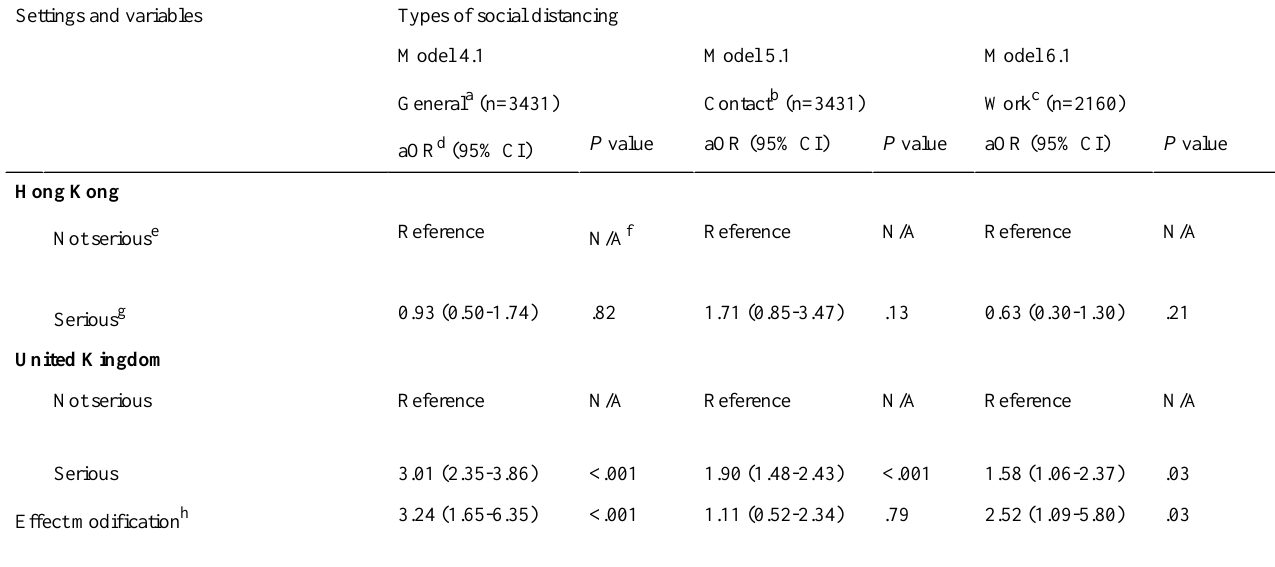
Table 4. Setting-specific effects and effect modification (by setting) of perceived severity on the adoption of social distancing measures. The models have been adjusted for all